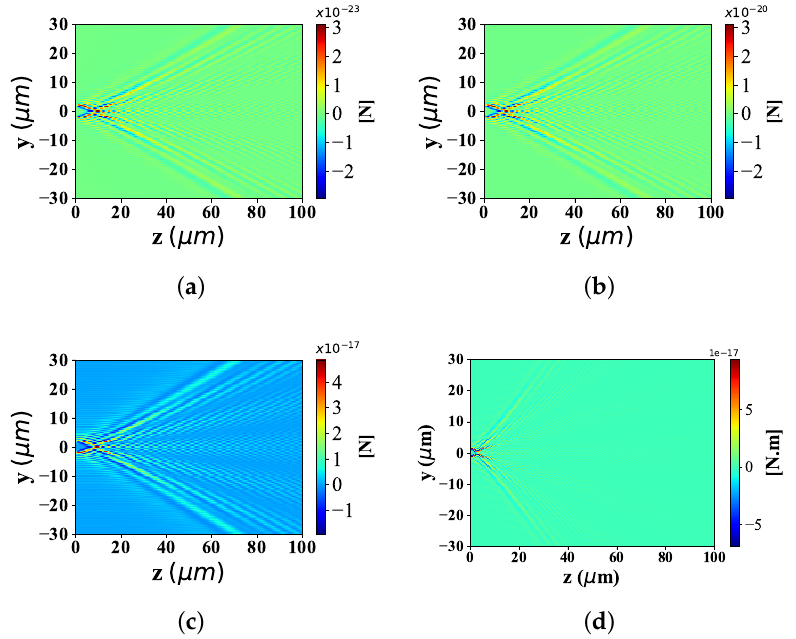
Figure 5. Distribution of F z under different spherical radius (radius is set to 0.001 λ , 0.01 λ , 0.1 λ and λ ) acting on Bessel pincer light-sheets beam ( λ = 0.532 µ m, α 0 = 0.5, and l = 10). ( a ) radius = 0.001 λ ; ( b ) radius = 0.01 λ ; ( c ) radius = 0.1 λ ; ( d ) radius = 1 λ